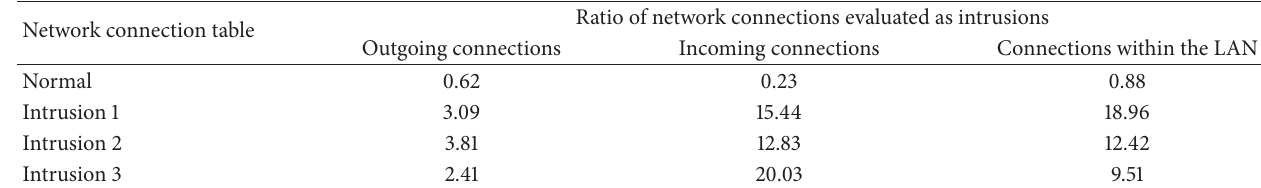
Table 2: Intrusion ratio of normal and abnormal data.